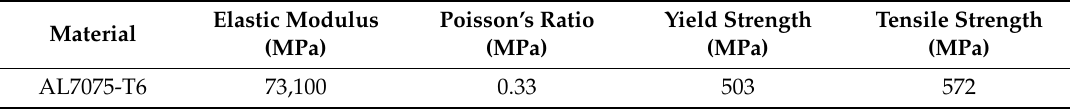
Table 1. Mechanical properties of 7075-T6 aluminum alloy plates.